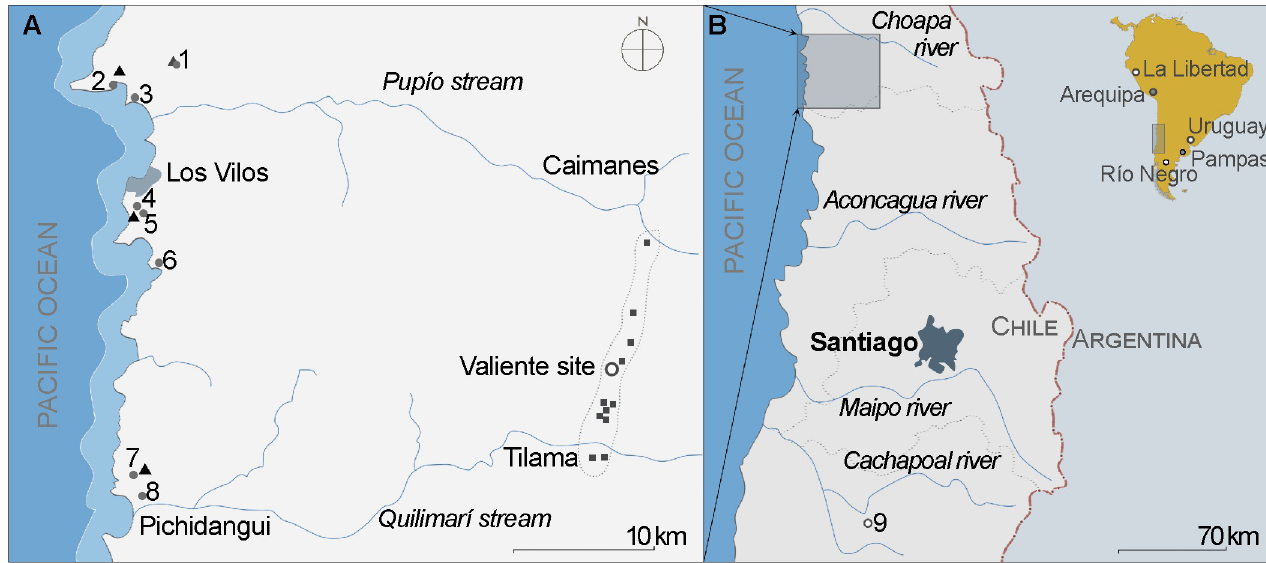
Fig 1. Map of the study area showing sites and regions discussed. A. Map at ~32˚ S, B. Central Chile, C. South America showing: archaeological sites (gray circles), archaeological sites with fishtail points in quartz (white circles), locations sampled for quartz natural distribution (squares), paleoenvironmental coring sites (triangles) discussed in this study. 1. Quebrada Santa Julia, 2. Punta N˜ague´, 3. Punta Penitente, 4. Quereo Norte, 5. Quereo Perfil, 6. Punta Purgatorio. 7. Palo Colorado, 8. Pichidangui, 9. Taguatagua 2.